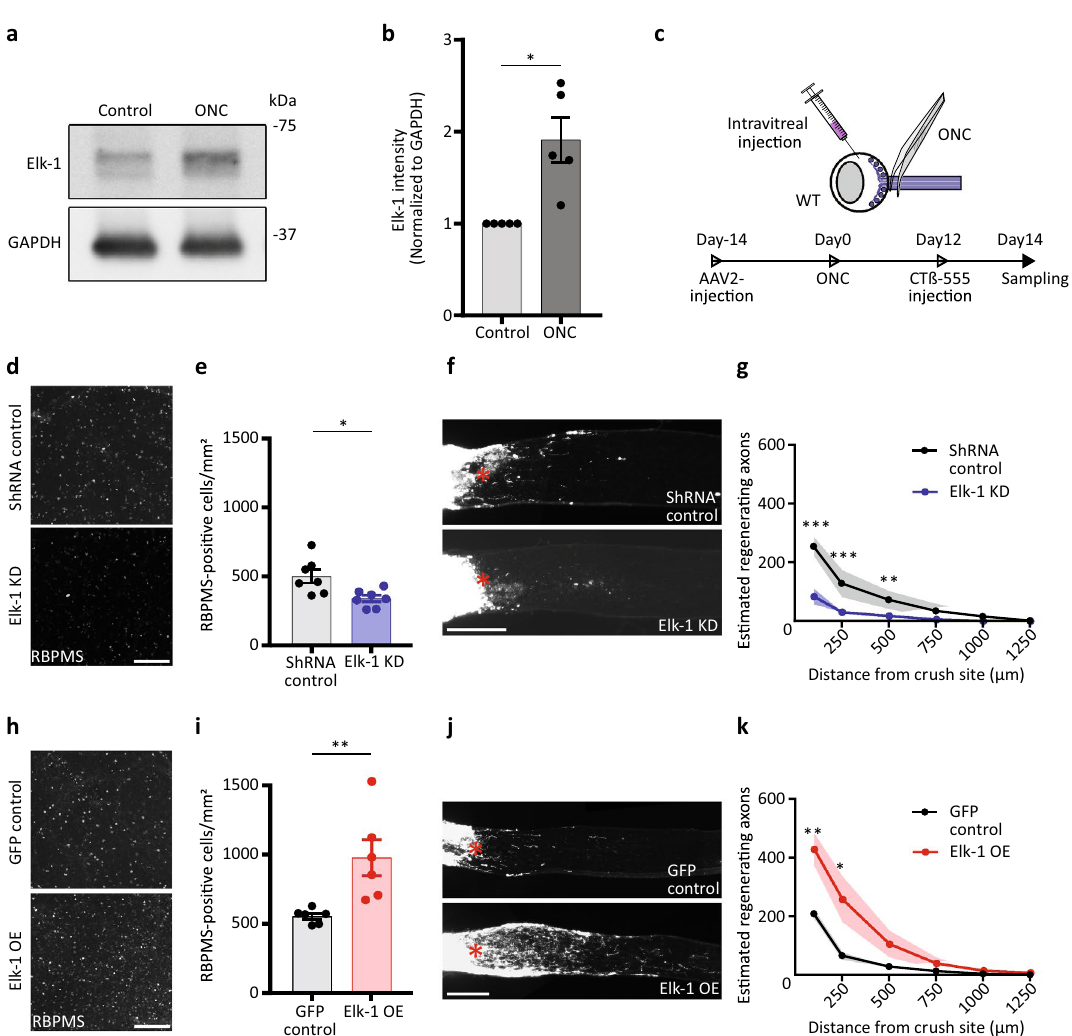
Figure 2. Elk-1 expression controls RGC survival and axon regeneration after optic nerve crush. ( a ) Expression of Elk-1 in whole retinas at 8 h after optic nerve injury and sham operation. Full blot in Supplemental Fig. S2. ( b ) Quantitative analysis of optic nerve injury-induced activation of Elk-1 in whole retinas in a . n = 5, * P < 0.05, two-tailed paired t-test ( c ) Experimental design and protocols of intravitreal injection and optic nerve injury. ( d ) Representative images show RBPMS (RGC marker) staining of RGCs at day 14 after optic nerve crush, for either AAV2-shRNA-Luciferase or AAV2-shRNA-Elk-1 injected WT mice. ( e ) Quantitative analysis of RBPMS- positive cell number in the retinas in ( d ). n = 7 per group, * P < 0.05, two-tailed Student’s t-test. ( f ) Representative images of the optic nerve sections showing CTB-labelled regenerating axons at day 14 after optic nerve injury, for either AAV2-shRNA-Luciferase or AAV2-shRNA-Elk-1 injected WT mice. Asterisks, lesion sites. ( g ) Quantitative analyses of estimated regenerating axons from the injury site in the optic nerves in ( f ). n = 5 per group, ** P < 0.01, *** P < 0.001, multiple t-tests. ( h ) Images show RBPMS staining of RGCs at day 14 after optic nerve crush, for either AAV2-GFP or AAV2-Elk-1 injected WT mice. ( i ) Quantitative analysis of RBPMS- positive cell number in the retinas in ( h ). n = 6 per group, ** P < 0.01, two-tailed Student’s t-test. ( j ) Images of the optic nerve sections showing CTB-labelled regenerating axons at day 14 after optic nerve injury, for